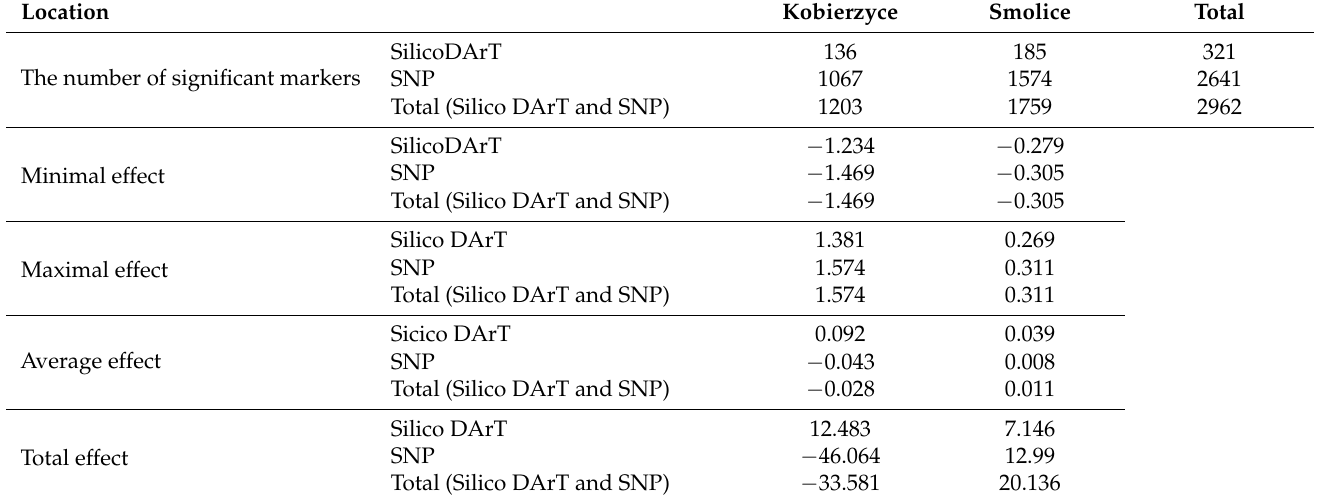
Table 3. Molecular markers of SilicoDArT and SNP significantly related to the resistance of maize to ear rot (significant associations selected at p < 0.05 corrected for multiple testing by the Benjamini- Hochberg